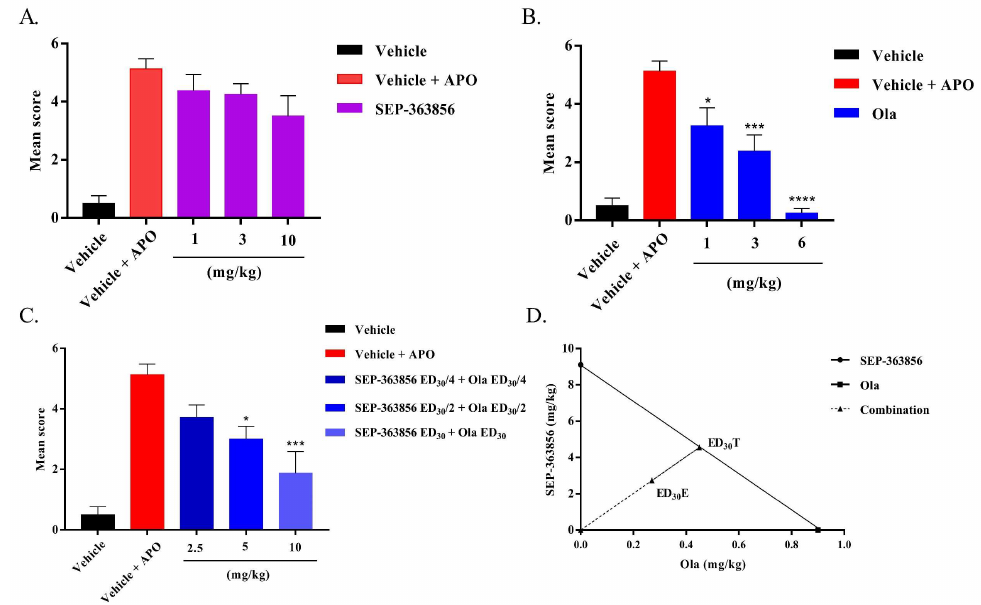
Figure 1. The effects of SEP-363856 and olanzapine on APO-induced climbing behavior in mice. Date expressed as mean ± S.E.M. ( n = 8). ( A ) Effect of SEP-363856 (1, 3, 10 mg/kg, p.o.) and ( B ) olanzapine (Ola: 1, 3, 6 mg/kg, p.o.) on APO-induced climbing in mice. ( C ) Effect of Ola and SEP-363856 co-administration on APO-induced climbing in mice. ( D ) The equi-effective combination of SEP-363856 and Ola produces a synergistic effect, as it falls below the line of additivity. For this graph, the derived ED 30 value of olanzapine was plotted on the abscissa and the ED 30 value of SEP-363856 was plotted on the ordinate. (In alone administration compared with model group, * p < 0.05, *** p < 0.001, **** p < 0.0001).